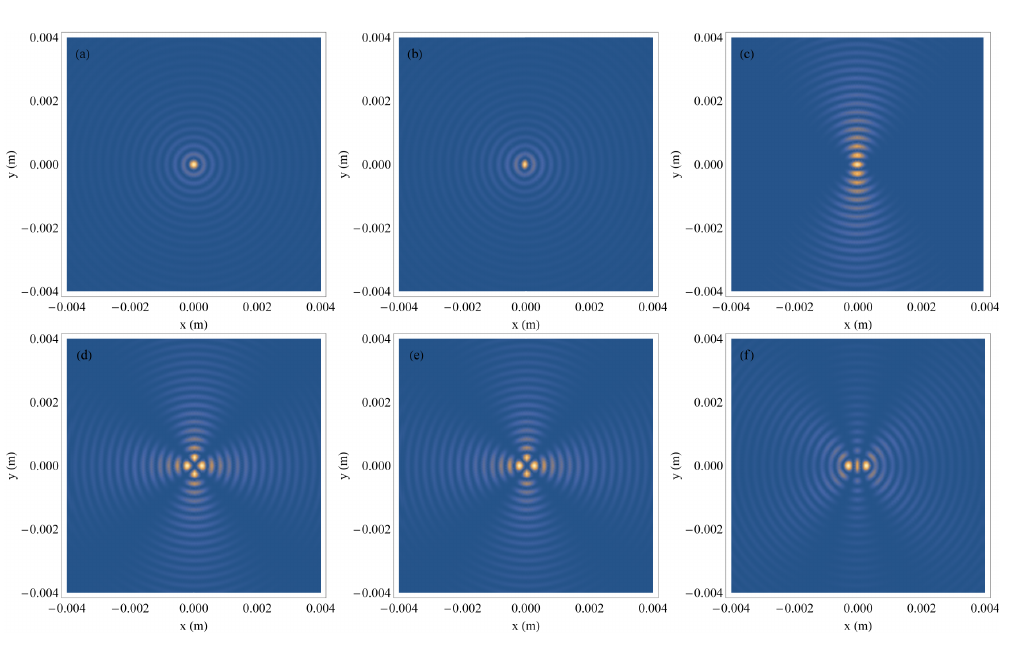
Figure 1. The transverse intensity pattern of Mathieu-Gaussian beam for ( a ) 2 l 0 = 0, q = 0, ( b ) 2 l 0 = 0, q = 0.2, ( c ) 2 l 0 = 0, q = 5, ( d ) 2 l 0 = 2, q = 0, ( e ) 2 l 0 = 2, q = 0.2, ( f ) 2 l 0 = 2, q = 5. The other beam parameters are w 0 = 0.01 m, λ = 532 nm, β =